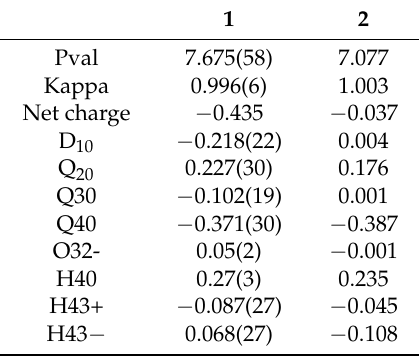
Table 6. D orbital populations (%) obtained from X-ray data ( 1 ), and from theoretical densities derived from theoretical multipolar parameters ( 2 ) following the method of Holladay et al.) [25].